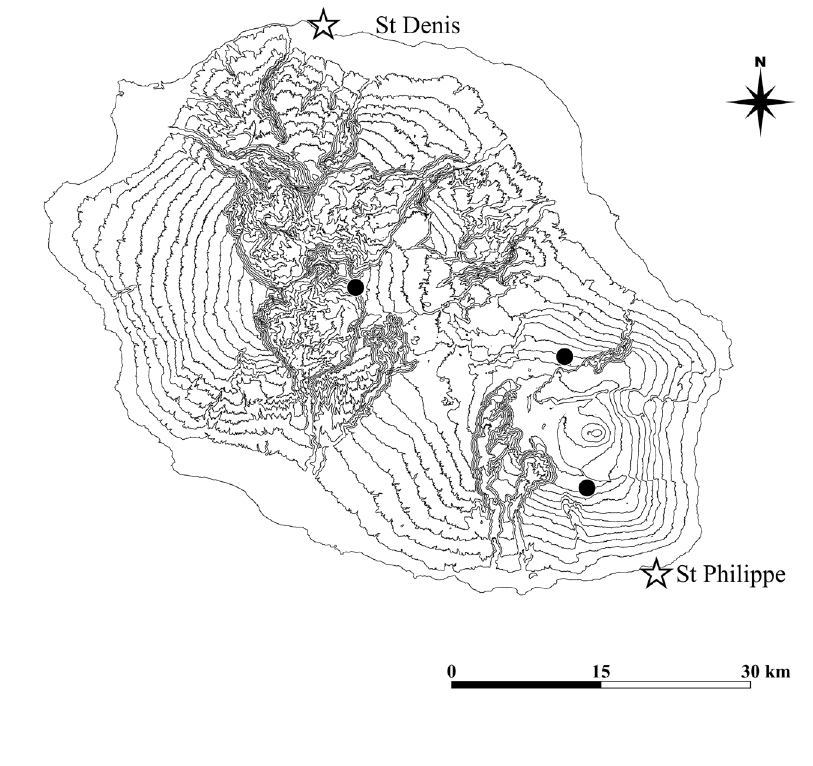
Figure 3 – Distribution géographique de Cynorkis borbonica. Les points noirs représentent les sous-populations. Carte réalisée avec QGIS version 3.8 (QGIS Development Team